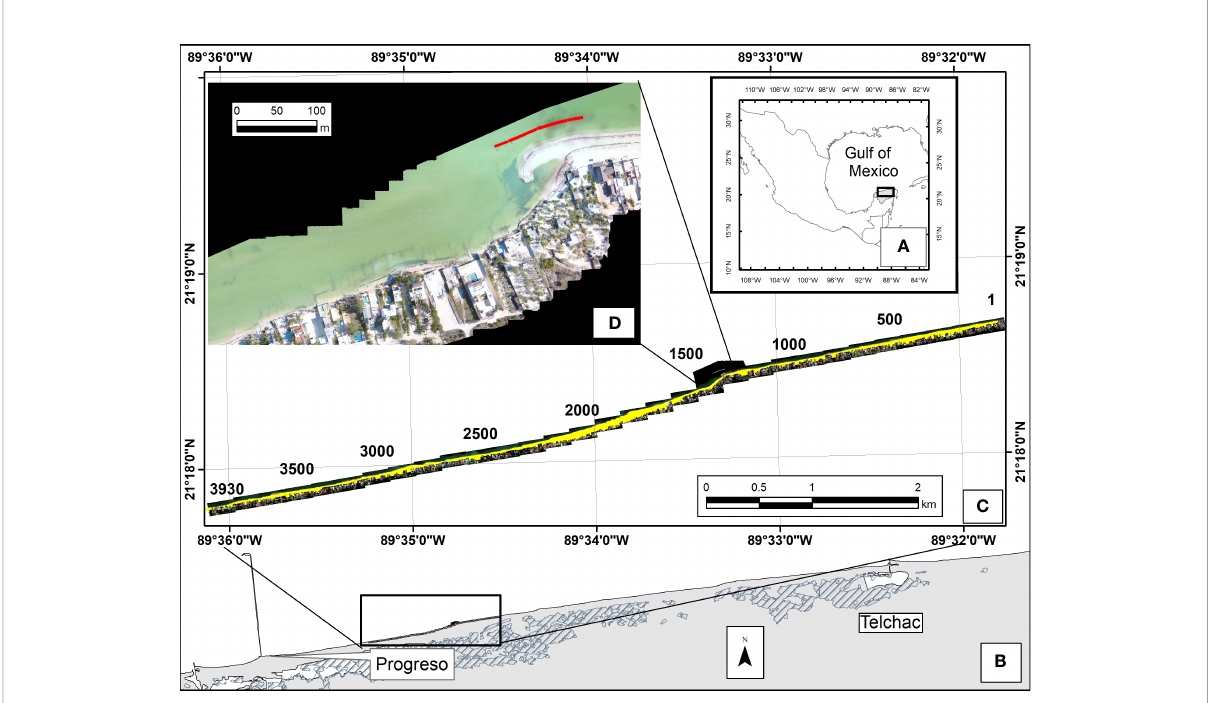
FIGURE 1 Study area location: (A) the beach stretch placed in the northern Yucatan Peninsula in the Gulf of Mexico; (B) between the ports of Progreso and Telchac. (C) the 7.8 km stretch was divided into 2-m transects numbered from east to west totaling 3930 transects. (D) detail of the Punta San Miguel with coastal structures (groins and geo textiles), infrastructure in the back part of the beach and vegetation coverage. The red line denotes the 120-m long low-crested detached breakwater made of geo textile tubes fi lled with